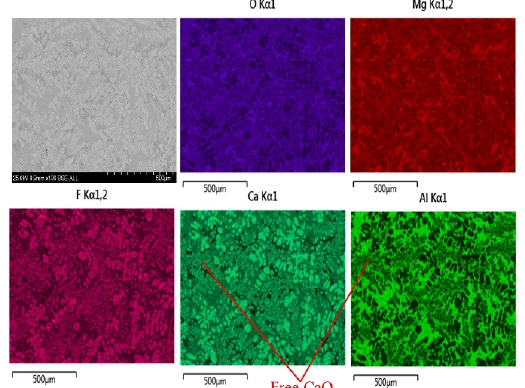
Figure 8. The element distribution diagram of slag T2 analyzed by SEM-EDS.